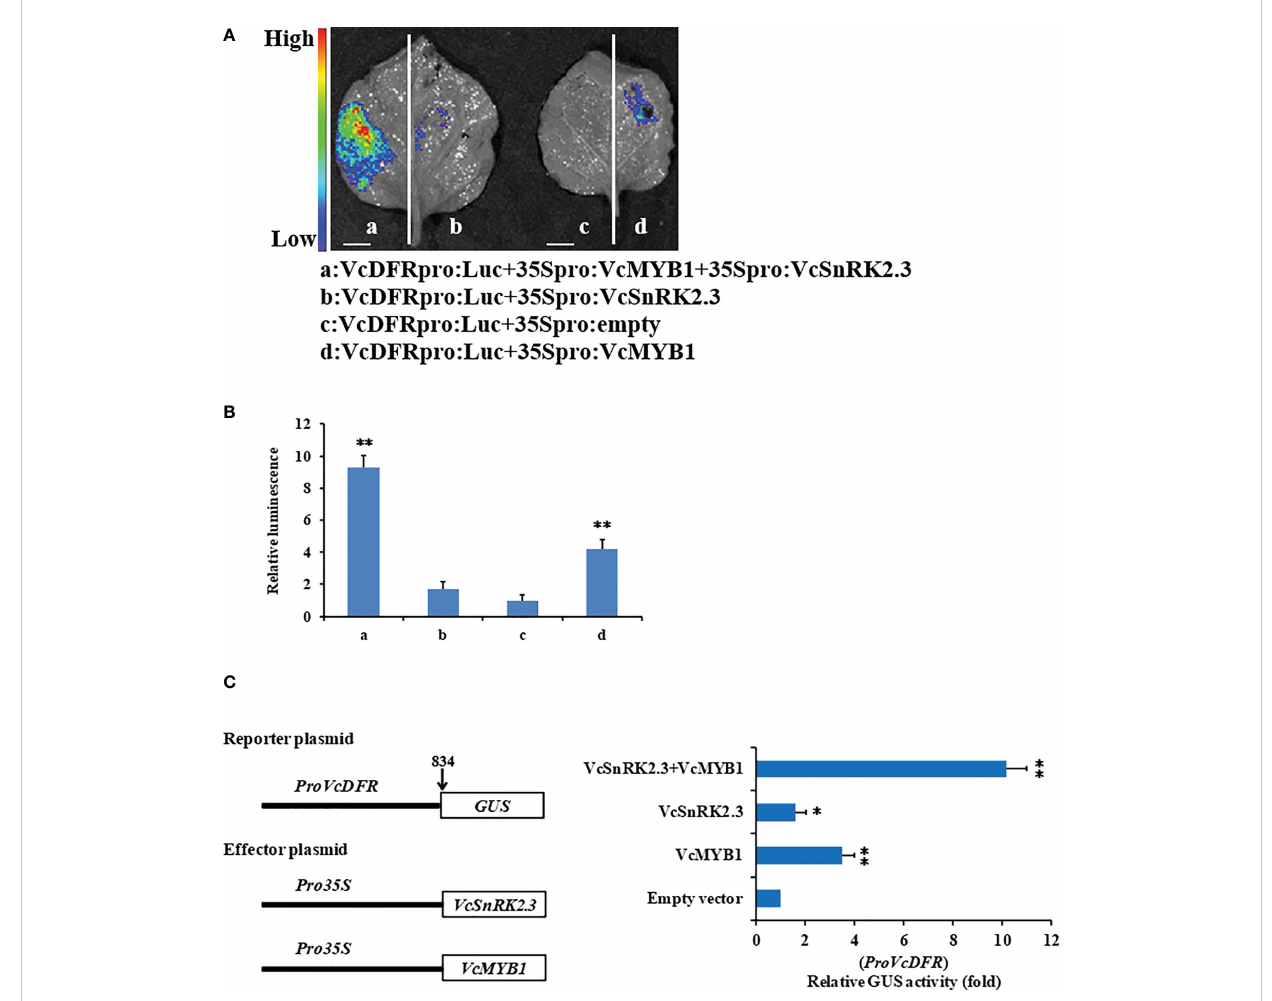
FIGURE 7 Regulation of VcDFR pro by VcMYB1 and VcSnRK2.3 . (A) Fire fl y luciferase complementation assay analysis showed that VcSnRK2.3 and VcMYB1 can activate VcDFR promoter activity in tobacco ( Nicotiana tabacum ) leaves. (a) VcDFR pro : Luc+35Spro : VcMYB1 + 35Spro : VcSnRK2.3 , (b) VcDFR pro : Luc+35Spro : VcSnRK2.3 , (c) VcDFR pro : Luc +35Spro:empty, (d) VcDFR pro : Luc+35Spro : VcMYB1 . Scale bar = 10 mm. (B) Quantitative analysis of luminescence intensity. The value for column c ( VcDFR pro : Luc+35Spro:empty) was set to 1. Different asterisks above the bars indicate signi fi